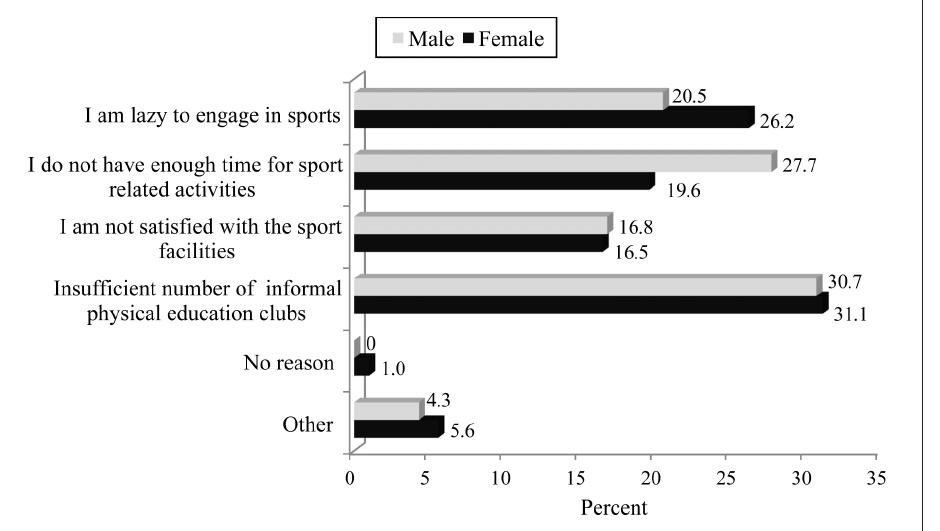
Figure 3. Main reasons for student inactivity